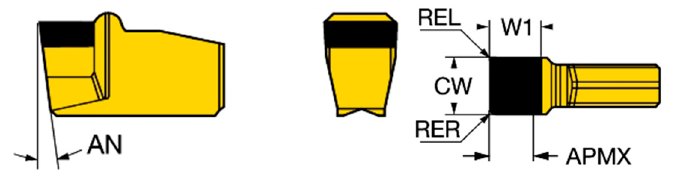
Figure 2. T-Max ® Q-Cut insert for grooving (N151.2-600-50E-G CB20) [11].